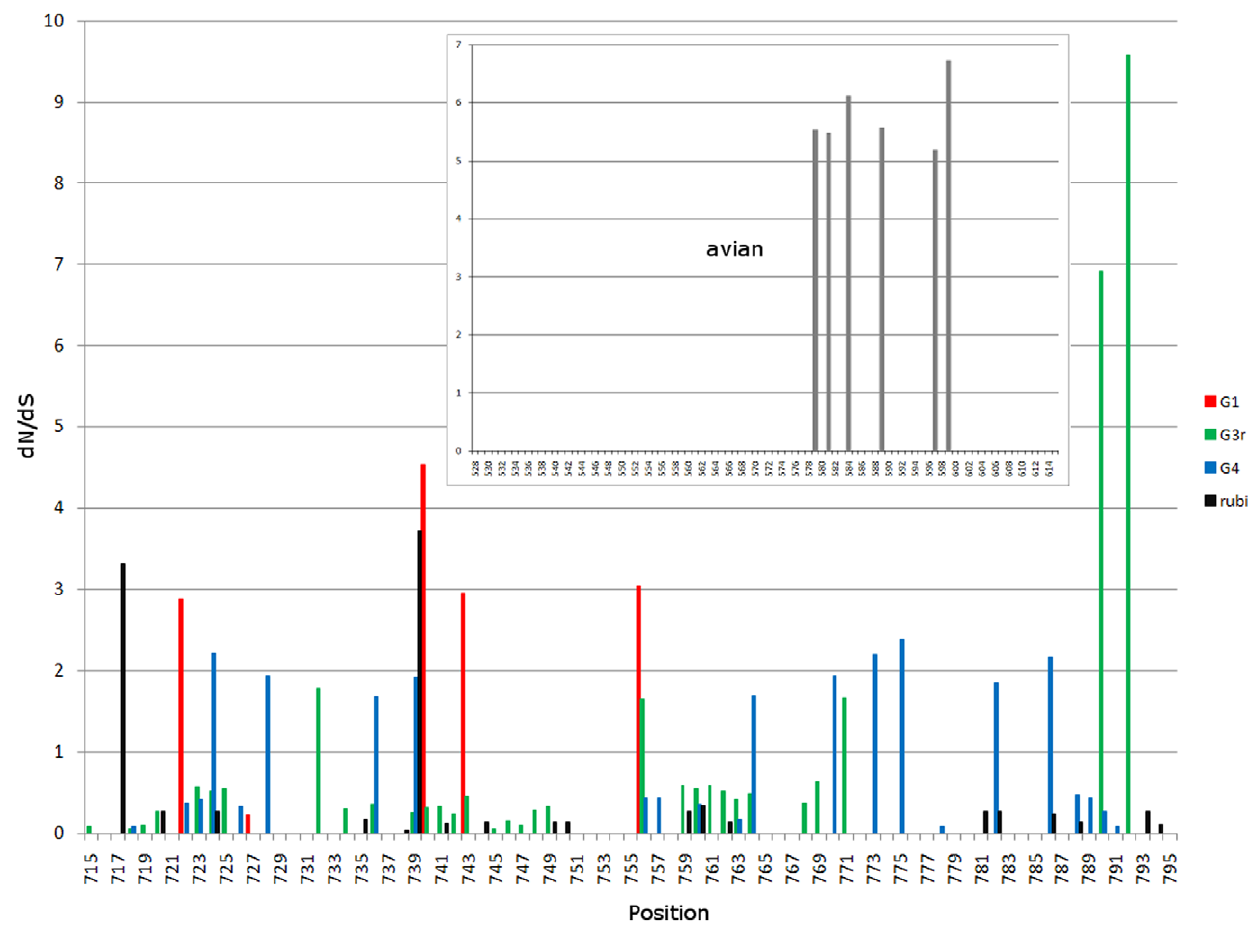
Figure 2. dN/dS values for rubivirus and HEV. For genotypes 1, 3 and 4, and rubivirus, results of analysis are shown across from aa positions 701 to 800, which includes the PPR IDR region. Values . 1 represent positions under positive selection. Insert shows dN/dS values for the PPR IDR of avian HEV (528 to 614 aa). There are no dN/dS values $ 1 in ORF1 outside the regions shown.